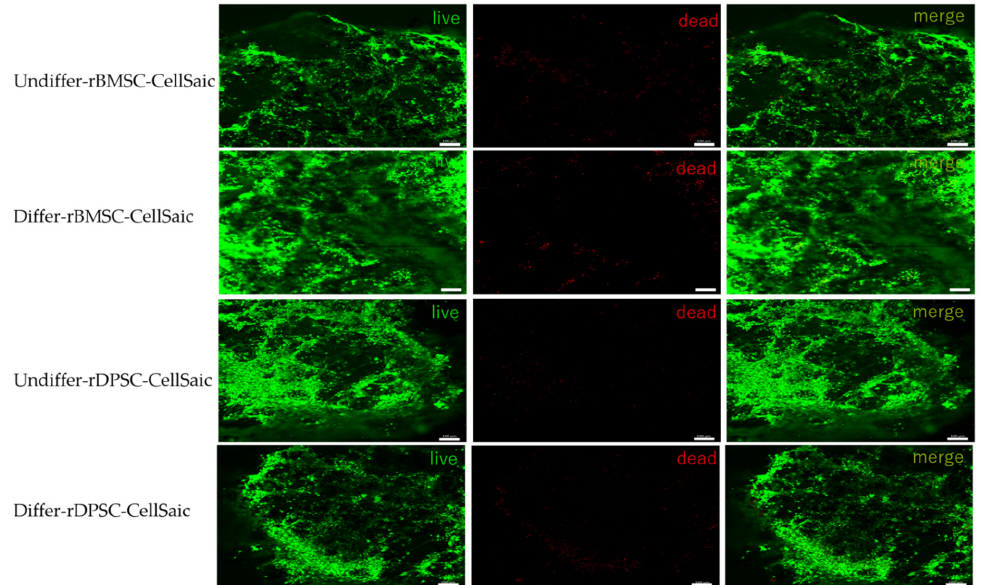
Figure 10. rBMSC-CellSaic and rDPSC-CellSaic were stained for live/dead staining after 21 days of differentiated and undifferentiated culture. Cells stained in green represent live cells, and in red represent dead cells. The cells are fusiform and adhere to each other. (Scale bar = 100 µm).